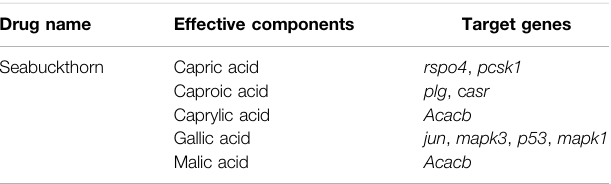
TABLE 2 | Predicted effective components and target genes from TCMID database.